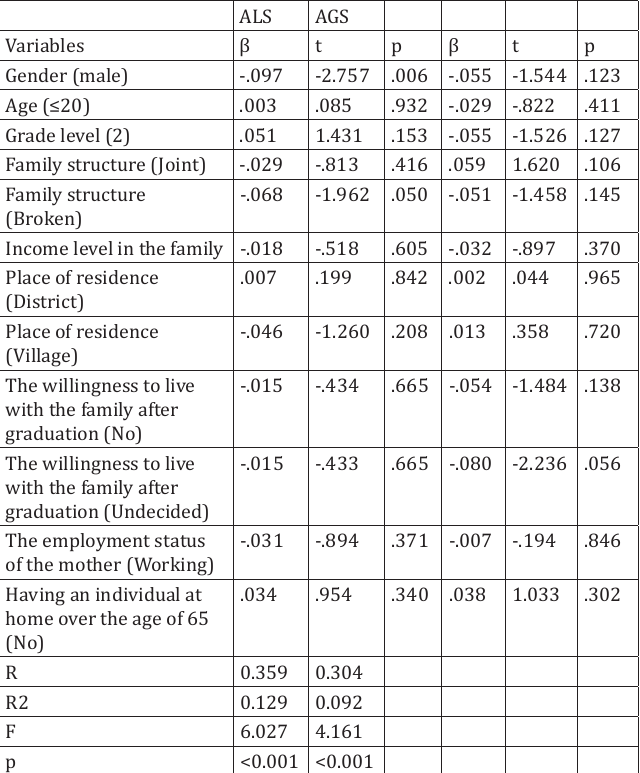
Multiple regression analysis on ALS and AGS according to socio-demographic characteristics